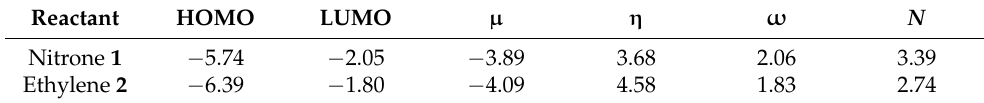
Table 1. CDFT global reactivity indices of nitrone 1 and ethylene 2 (in eV).